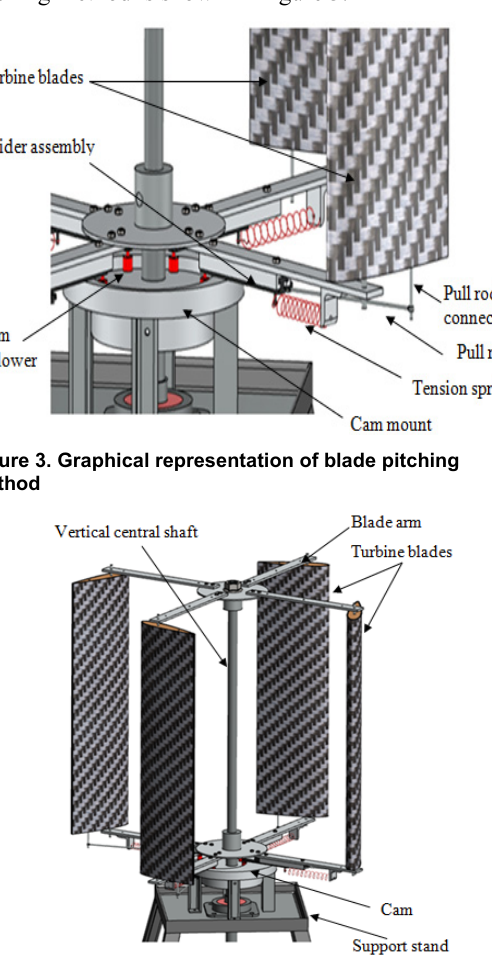
Figure 4. Wind turbine with various